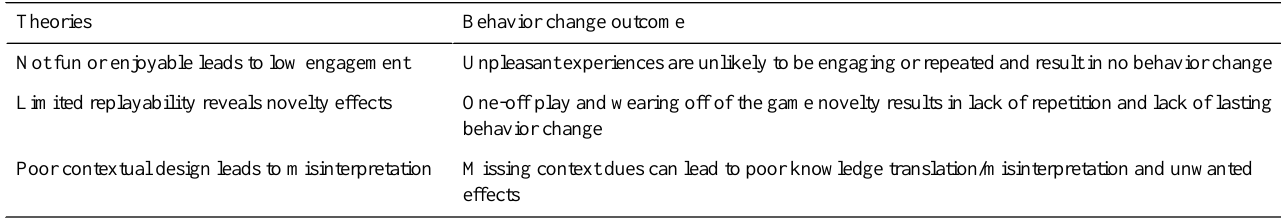
Table 3. Theories for games targeting behavior leading to poor behavior change outcomes. Behavior change